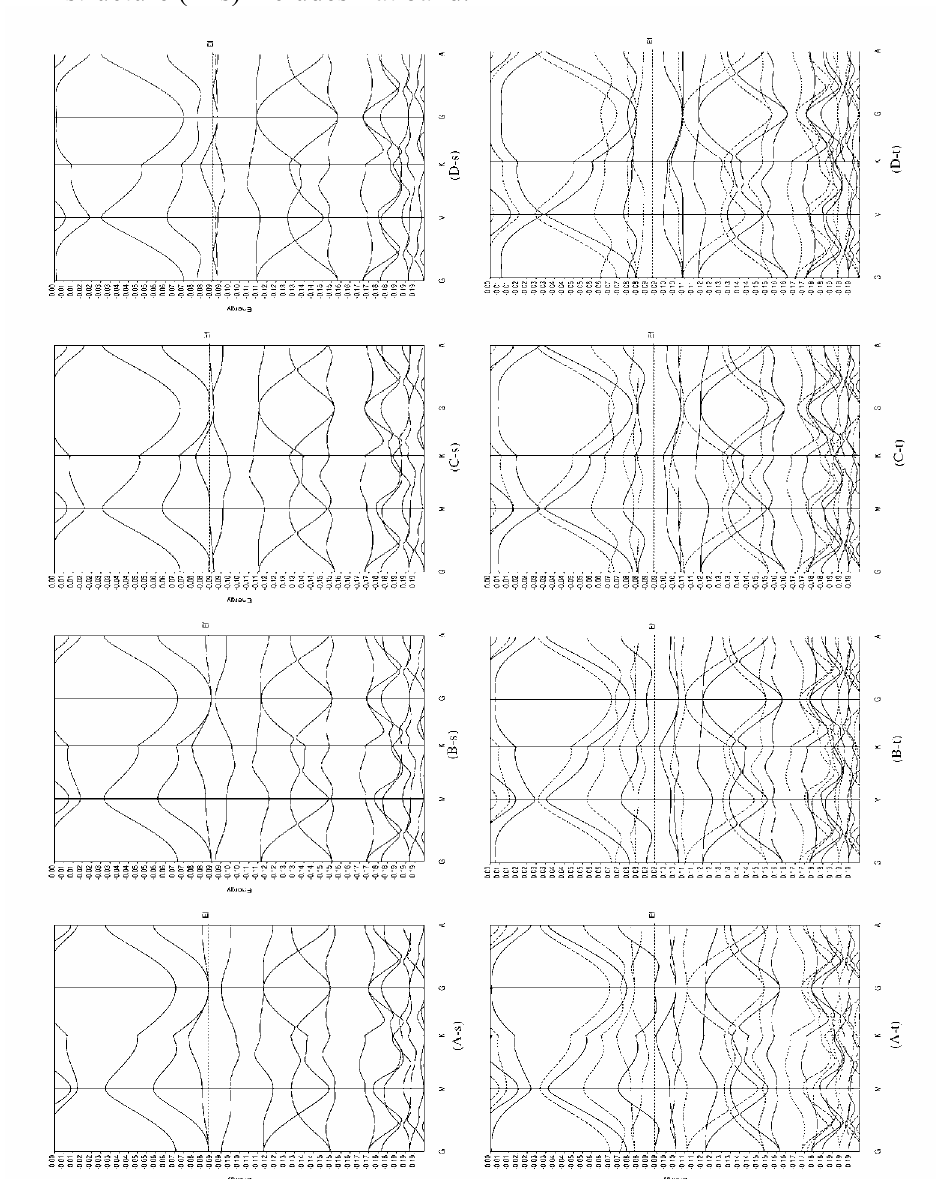
The upper four band structures (X-s: X=A, B, C, D) correspond singlet Rh -C with distortion (A) d = 9.14, (B) d = 9.97, (C) d = 10.80, (D) d = 11.63, respectively. Similarly, the lower four band structures (X-t: X=A, B, C, D) correspond triplet Rh-C with distortion (A) d = 9.14, (B) d = 9.97, (C) d = 60 10.80, (D) d = 11.63, respectively. Atomic unit was used for energy. The band structure (D-s) includes flat